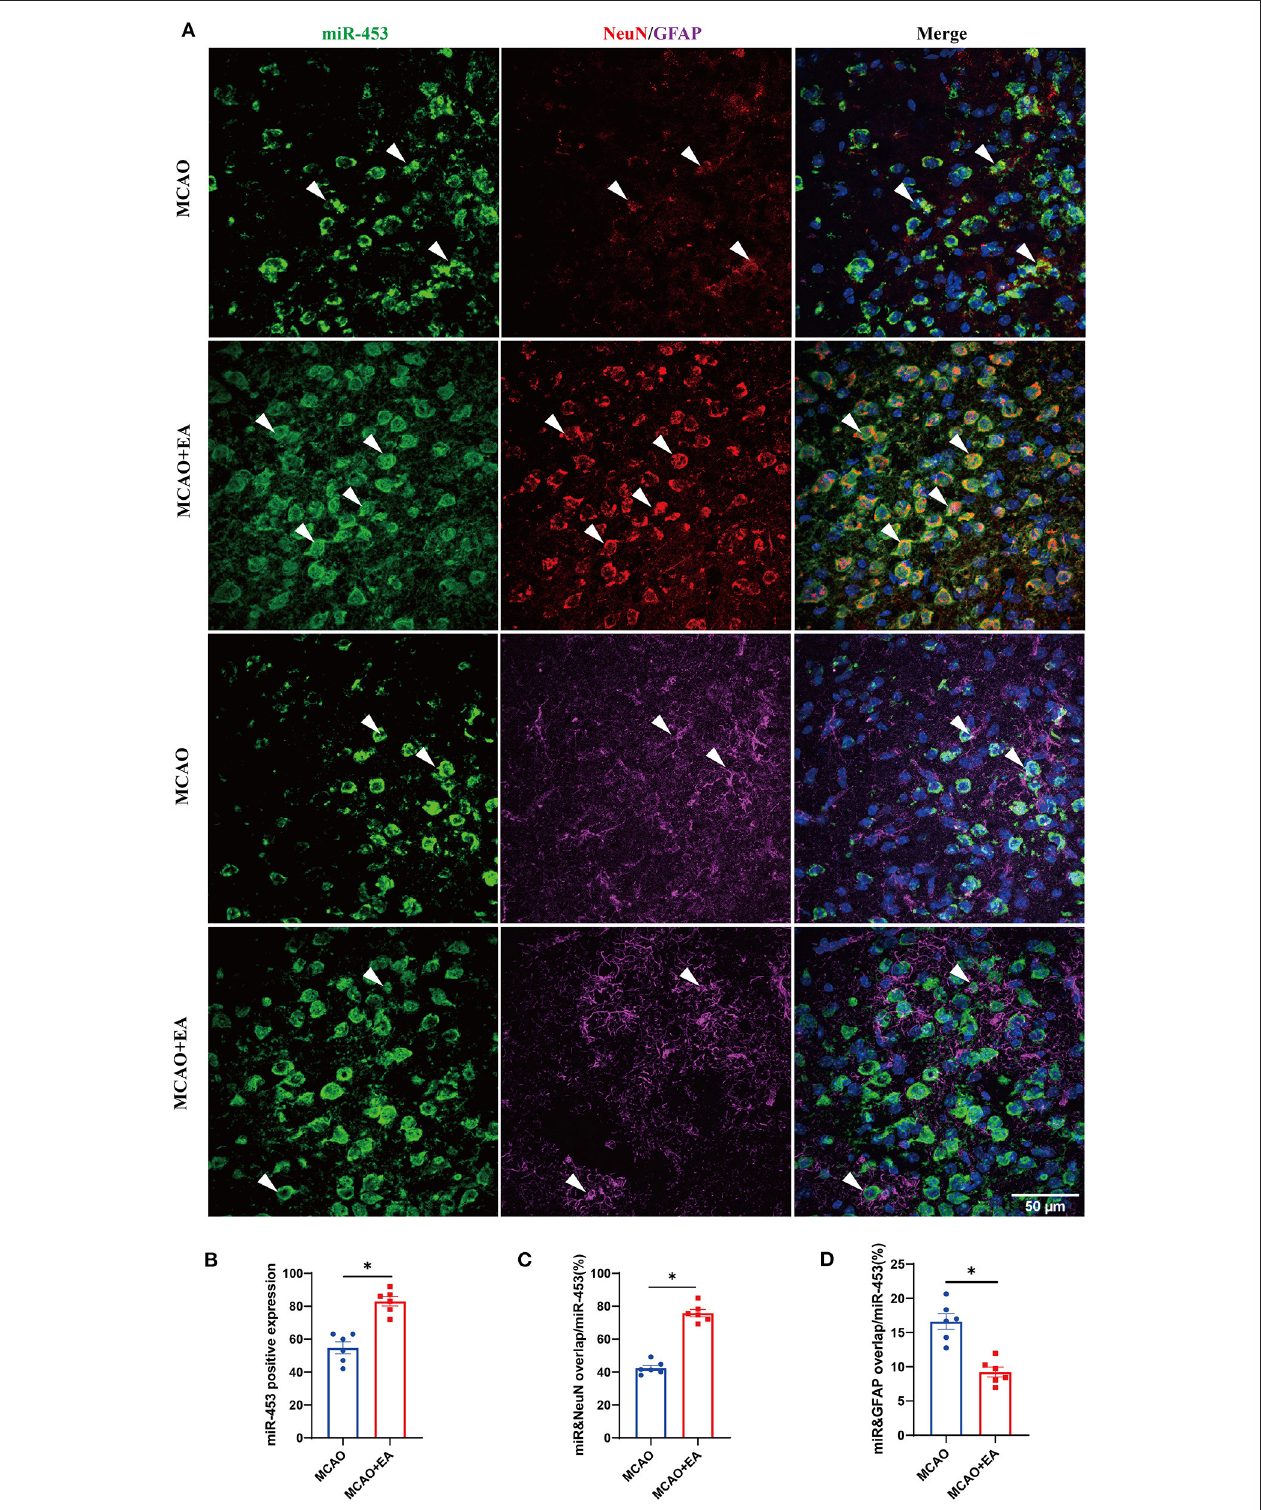
FIGURE 9 | The localization of miRNA (miR-453) regulated by EA in ischemic stroke. (A) Confocal microscopic images showing the localization of miRNA (miR-453) (represented in green) with neuronal marker (NeuN, red) and astrocytic marker (GFAP, magenta) in the brain cortex regions of mice subjected to MCAO +